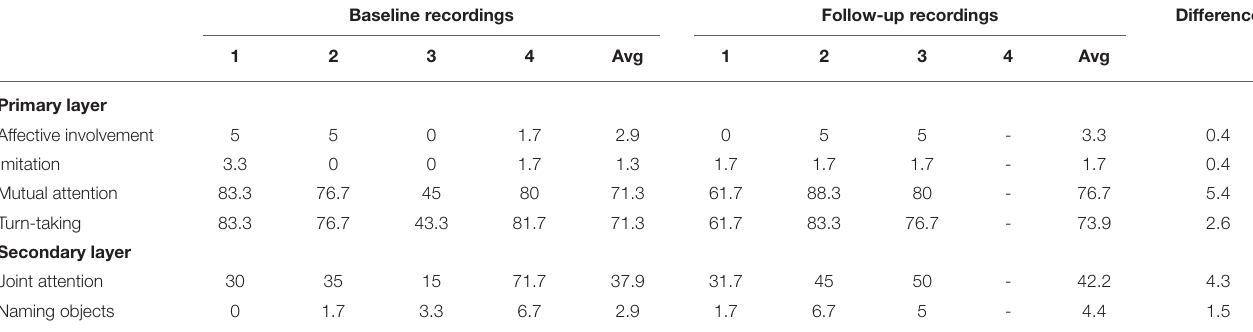
TABLE 6 | Percentage presence of LCM behaviors and difference in presence between baseline and follow-up recordings for dyad 4. Baseline recordings Follow-up